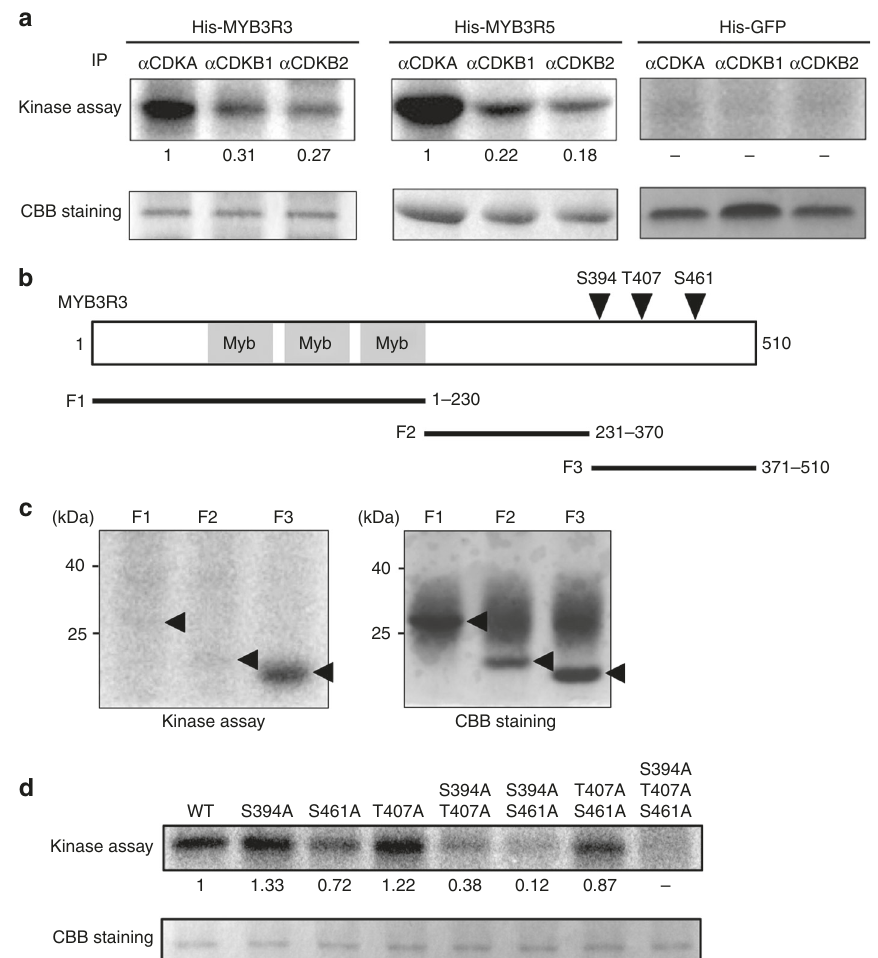
Fig. 5 CDK phosphorylates MYB3R3 and MYB3R5. a In vitro kinase assay of His-MYB3R3 and His-MYB3R5. Protein extracts from Arabidopsis MM2d cultured cells were immunoprecipitated with speci fi c antibodies against CDKA, CDKB1 and CDKB2, and assayed for kinase activity using His-MYB3R3 or His-MYB3R5 as substrate. His-GFP was used as a control. Relative intensity of each band is expressed as the fold change, normalized with respect to the band of substrates visualized by CBB staining. b Schematic representation of MYB3R3 harbouring three Myb domains. Arrowheads indicate CDK phosphorylation sites in the C-terminal region. Black bars indicate protein fragments used for kinase assay in c . c Kinase assay of partial fragments of MYB3R3. Protein extracts from MM2d cells were immunoprecipitated with the anti-CDKA antibody and assayed for kinase activity using His-tagged fragments of MYB3R3 (F1, F2 and F3) as substrate. Arrowheads indicate the position of each substrate. d Kinase assay of His-MYB3R3 with alanine substitutions. Protein extracts from MM2d cells were immunoprecipitated with the anti-CDKA antibody and assayed for kinase activity using His-MYB3R3 with alanine substitutions at CDK phosphorylation sites as substrate. Relative intensity of each band is expressed as the fold change, normalized